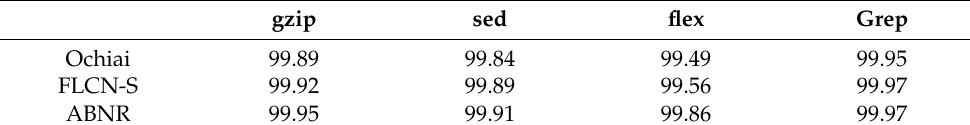
Table 9. Denote the confidence level of fault detection from Unix utility applications.